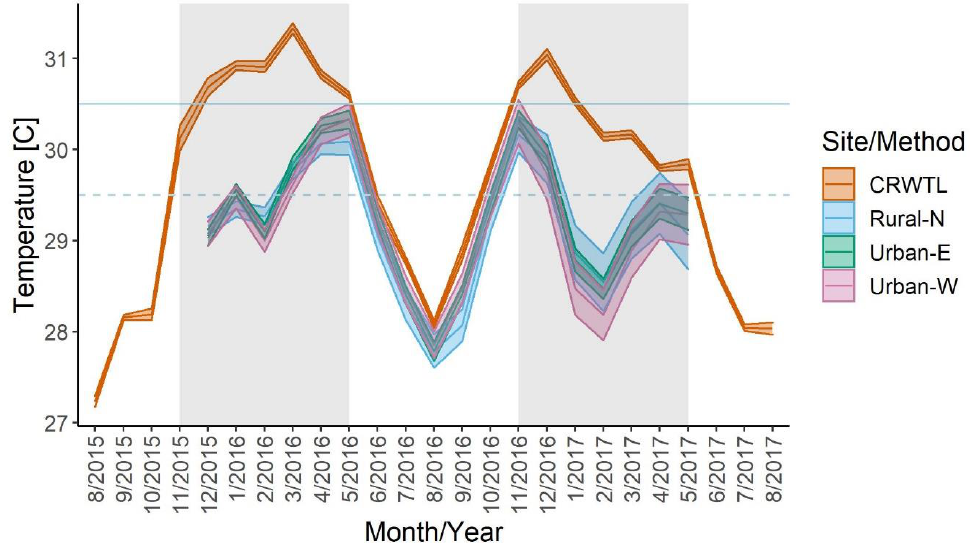
Figure 7. Mean temperature by month ± 2 standard error of the daily maximum temperature for remotely sensed sea surface temperature (5 km 2 pixels) from Coral Reef Watch Timor-Leste (CRWTL) and in situ temperature loggers pooled by depth ( n = 6). Loggers sampled every 30 min between November 2015 and July 2017, the period between benthic surveys. The gray shading indicates the annual monsoon season from November to May. The dashed blue line is the maximum monthly mean (MMM, 29.5 °C) from the CRWTL data and the solid blue line is MMM + 1 °C (30.5 °C), the bleaching threshold for accumulation of degree heating weeks. Comparison of the monthly means of all in situ temperature loggers with the monthly means of the CRWTL SSTs showed they were significantly different by a season and method interaction [two-way ANOVA: χ 2 (3) = 8.2054, p = 0.0420]. Pairwise tests for this interaction revealed that the CRWTL satellite-derived SST values were not